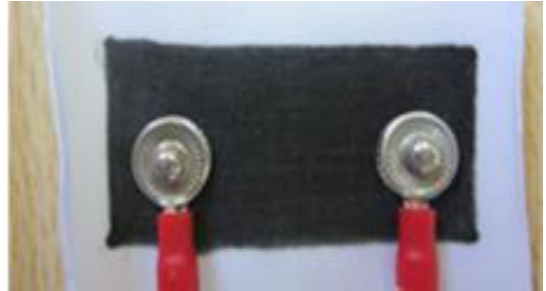
Figure 1. Body Worn Sensor (BWS) used in development of Trunk Motion System (TMS). Metal snap buttons used to create the needed electrical connections between the BWS and lead wires.